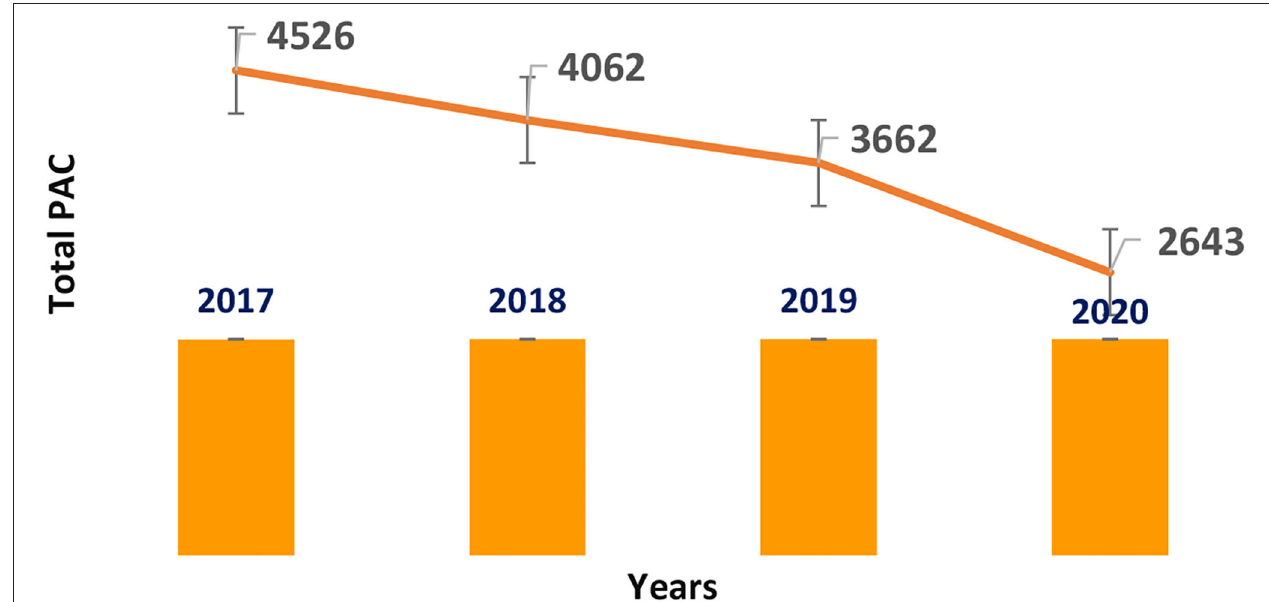
FIGURE 6 | Post-approval changes submitted in Costa Rica (2017–2020) small